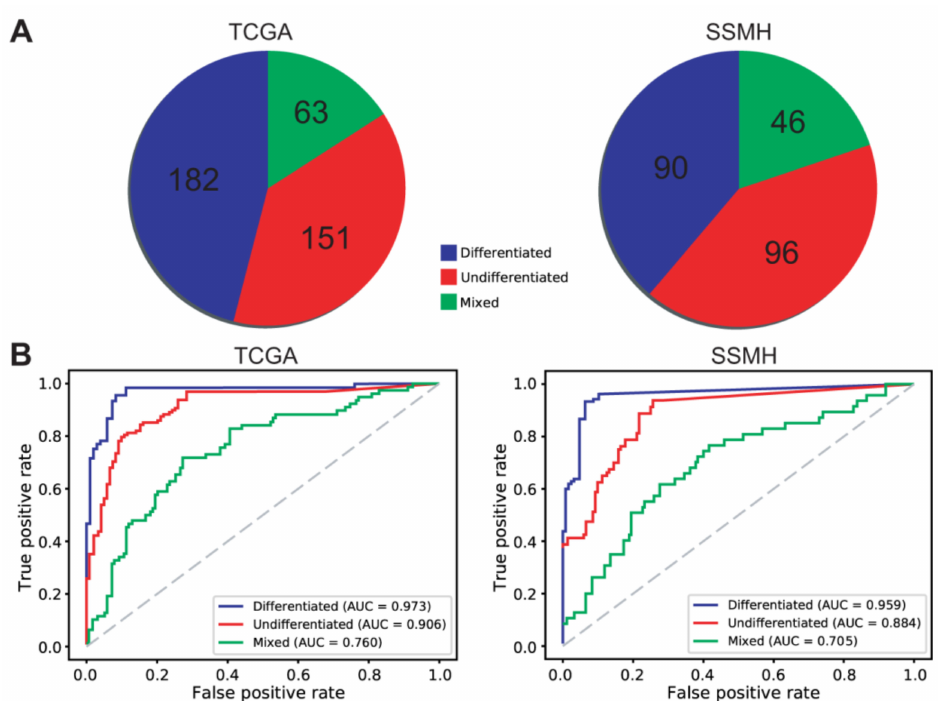
Figure 6. Slide-level classification results of the differentiated/undifferentiated classifier for the TCGA and SSMH datasets. ( A ) Pathologists’ classification for the TCGA and SSMH datasets. ( B ) The slide-level receiver operating characteristic (ROC) curves of the differentiated/undifferentiated classifier for the TCGA and SSMH